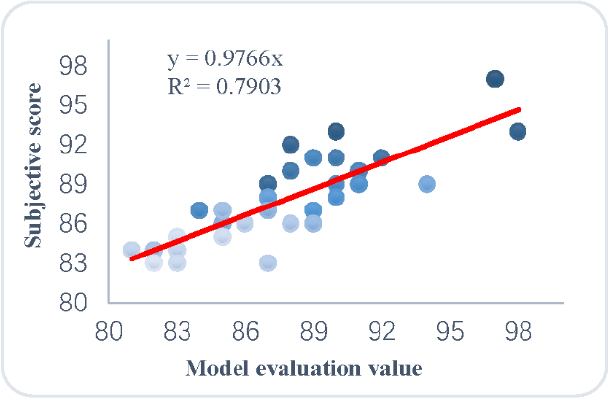
Fig. 6 Evaluation correlation analysis of subgrade and pavement.